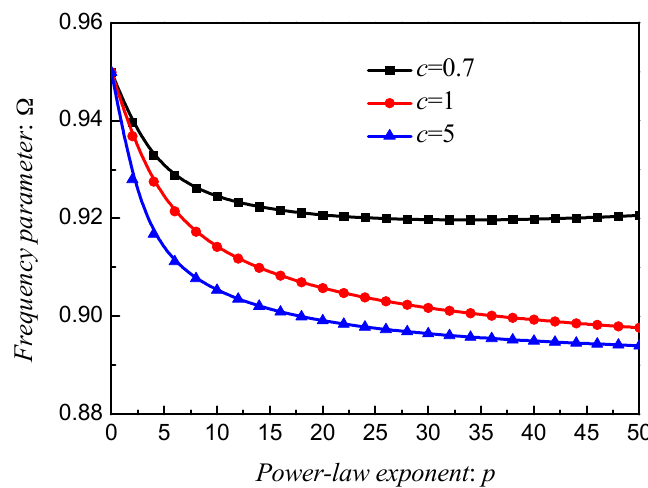
Figure 11. Results about different p and b of stepped FGM I ( a = 1; b , c = 2; p ) paraboloidal shell.